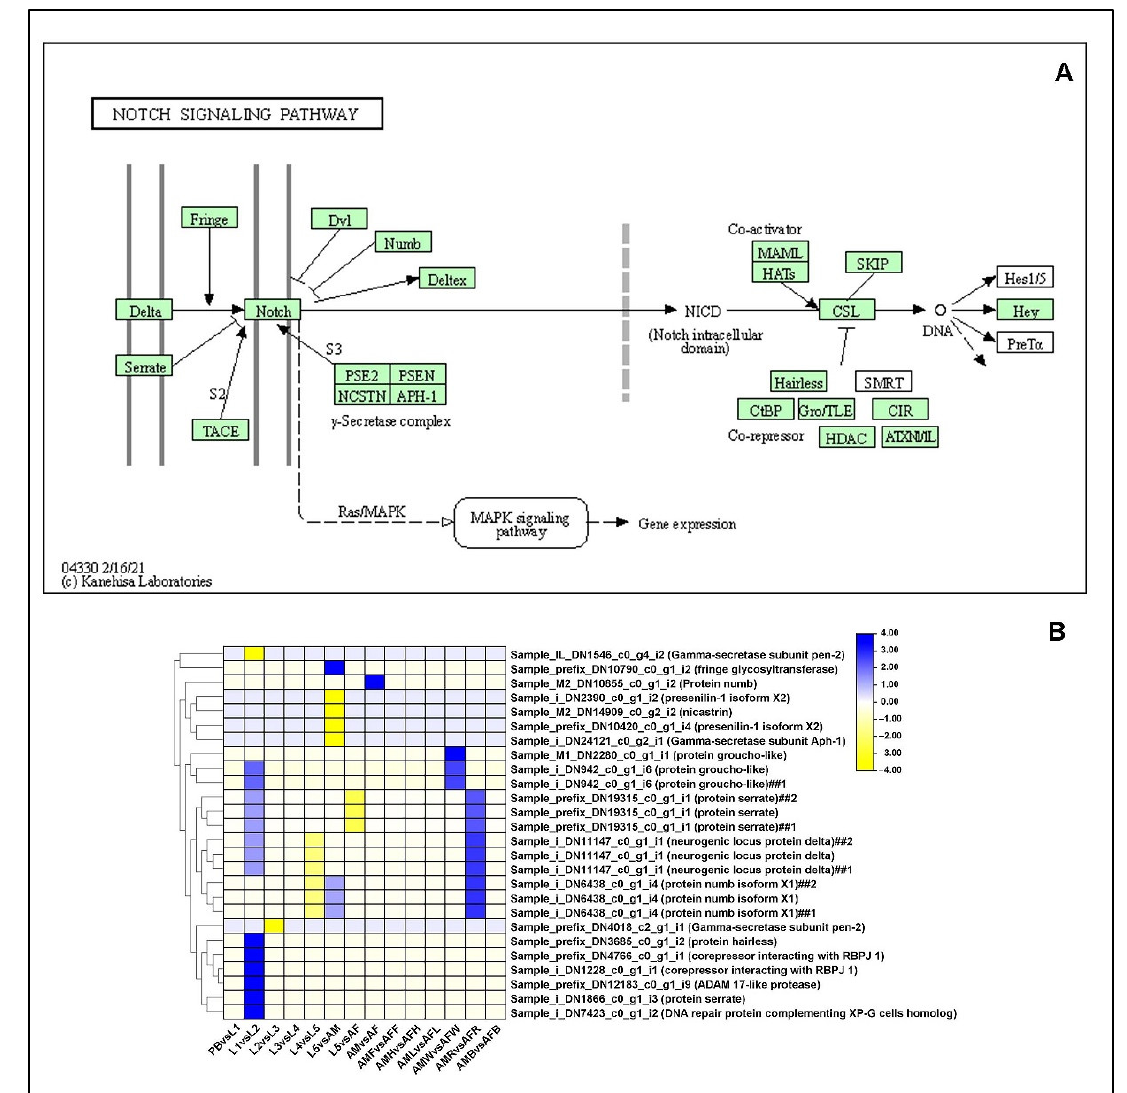
Figure 10. Identification of genes assigned to the Notch signaling pathway in the P. bremeri transcriptome. KAAS was used to identify genes annotated by BLAST against the specific insect database and assigned to a KEGG pathway ( A ) Notch signaling pathway components/genes. Colored boxes indicate the presence of the genes identified. A green colored box signifies the presence of an annotated gene that does not show a change in expression levels. ( B ) Heat map showing the log2-fold change of the FPKM values of the DEGs.